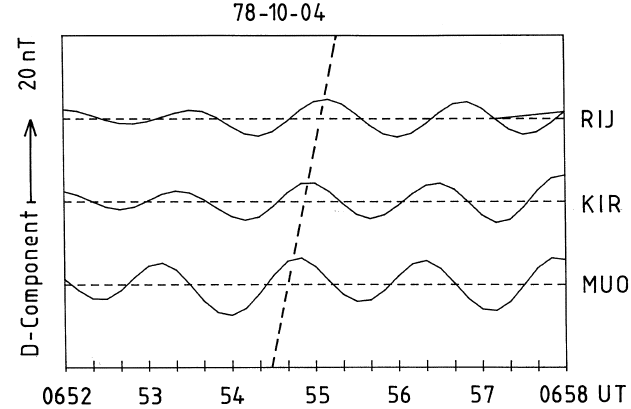
Fig. 3. Magnetic field variations recorded along the three east-west aligned stations RIJ, KIR, and MUO. Geomagnetic latitude of the three stations is 64 : 8 (cid:14) (cid:6) 1 (cid:14) . The dashed line connects corresponding maxima at the